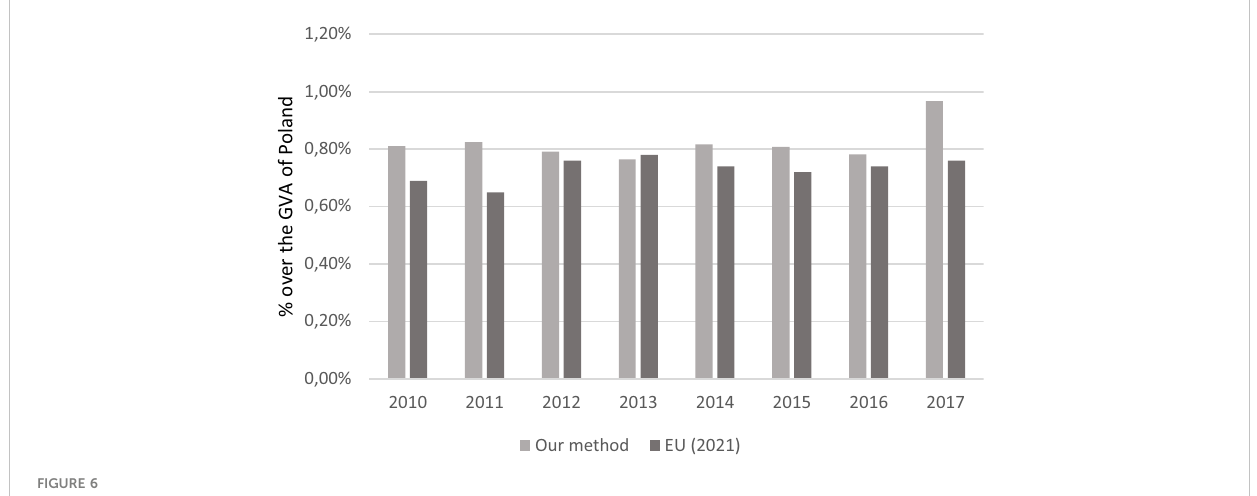
FIGURE 6 Comparison of results obtained by both studies. Source: own